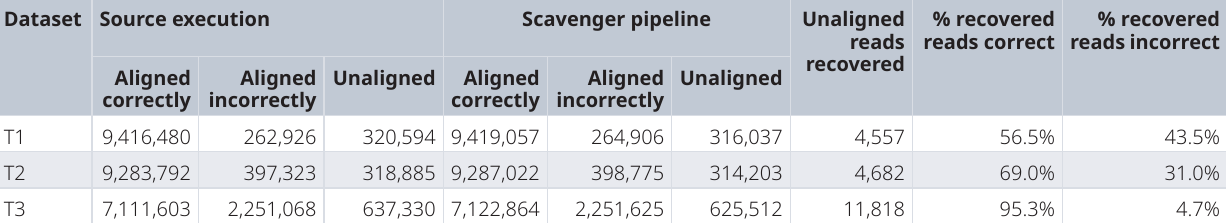
Table 8. Alignment statistics for simulated datasets before and after Scavenger recovery using optimised parameters for